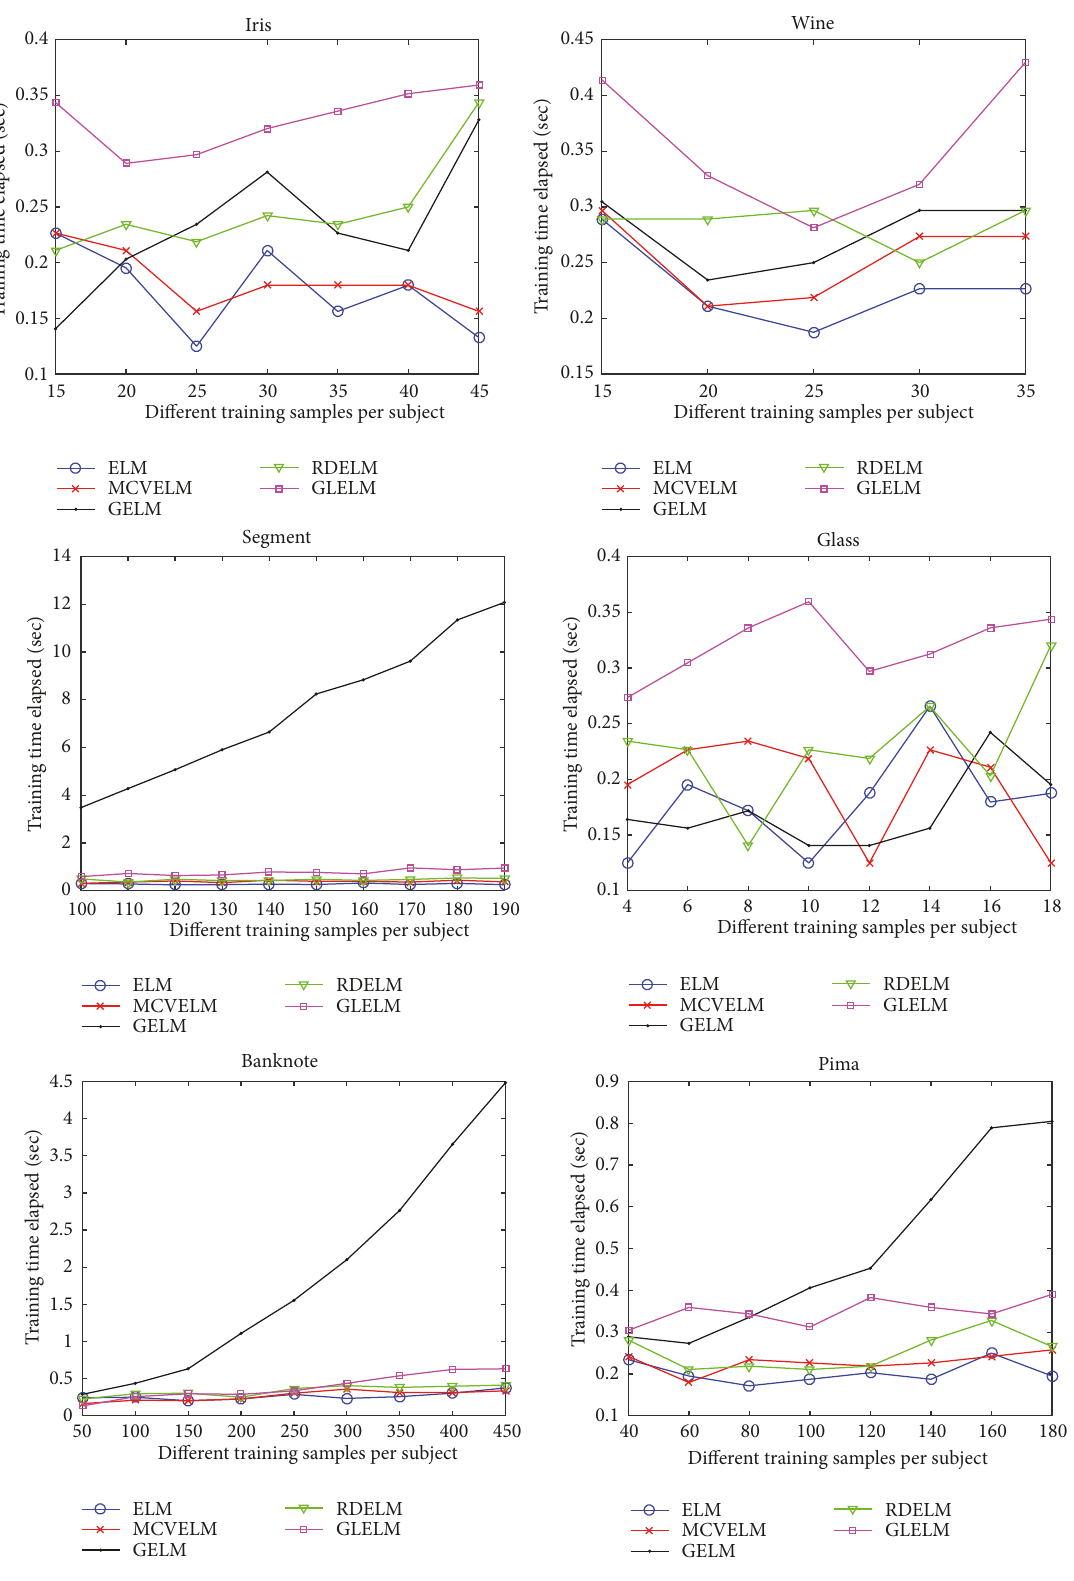
Figure 5: Different ELM algorithm training time curves on UCI datasets and image datasets Iris, Wine, Segment, Glass, Banknote, Pima, ORL, Yale, Yale B, COIL20, MNIST, and